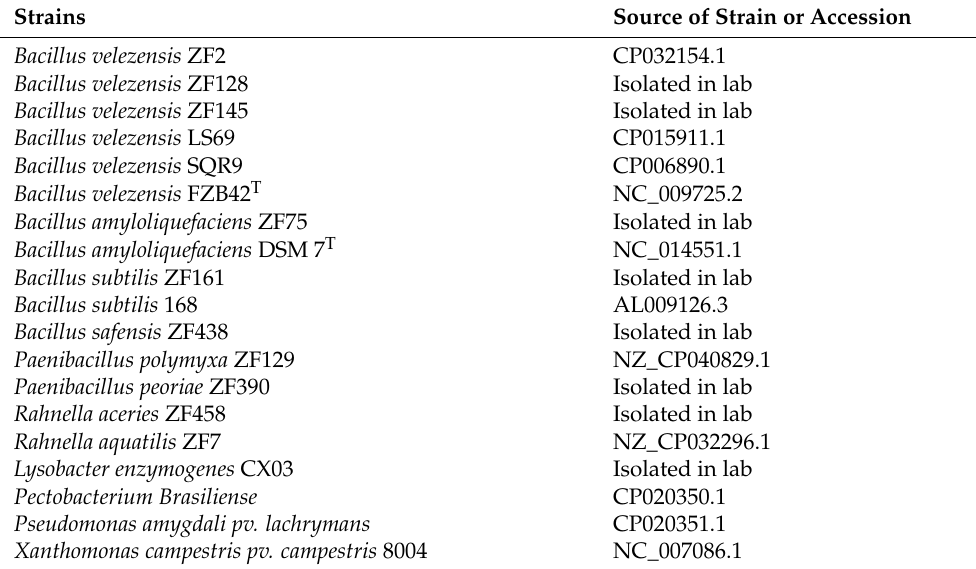
Table 1. Reference strains used in this